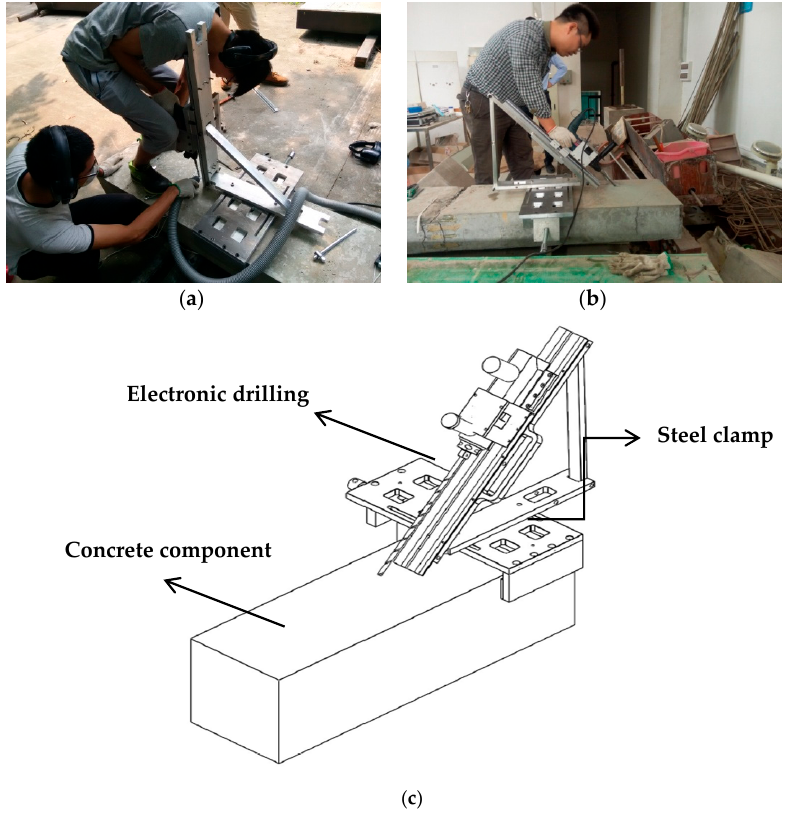
Figure 6. Details of invented drilling equipment: ( a ) Vertical drilling; ( b ) Inclined drilling; ( c ) Drilling